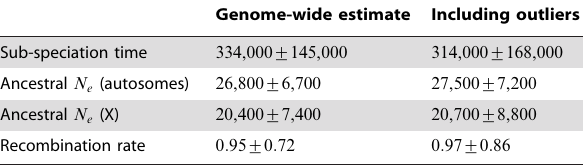
Table 1. Genome-wide parameter estimates.